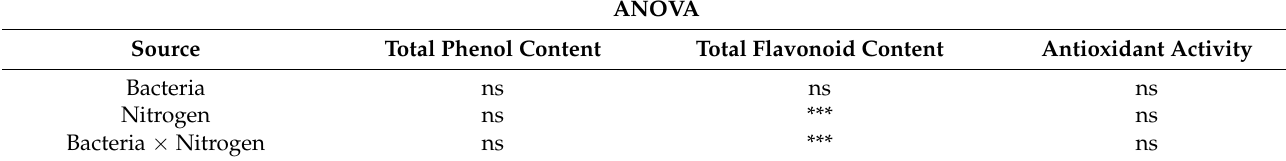
Table 5. Total phenol content, total flavonoid content and antioxidant activity in hydroponically grown lettuce influenced by Azotobacter under different nitrogen levels. Significant differences: